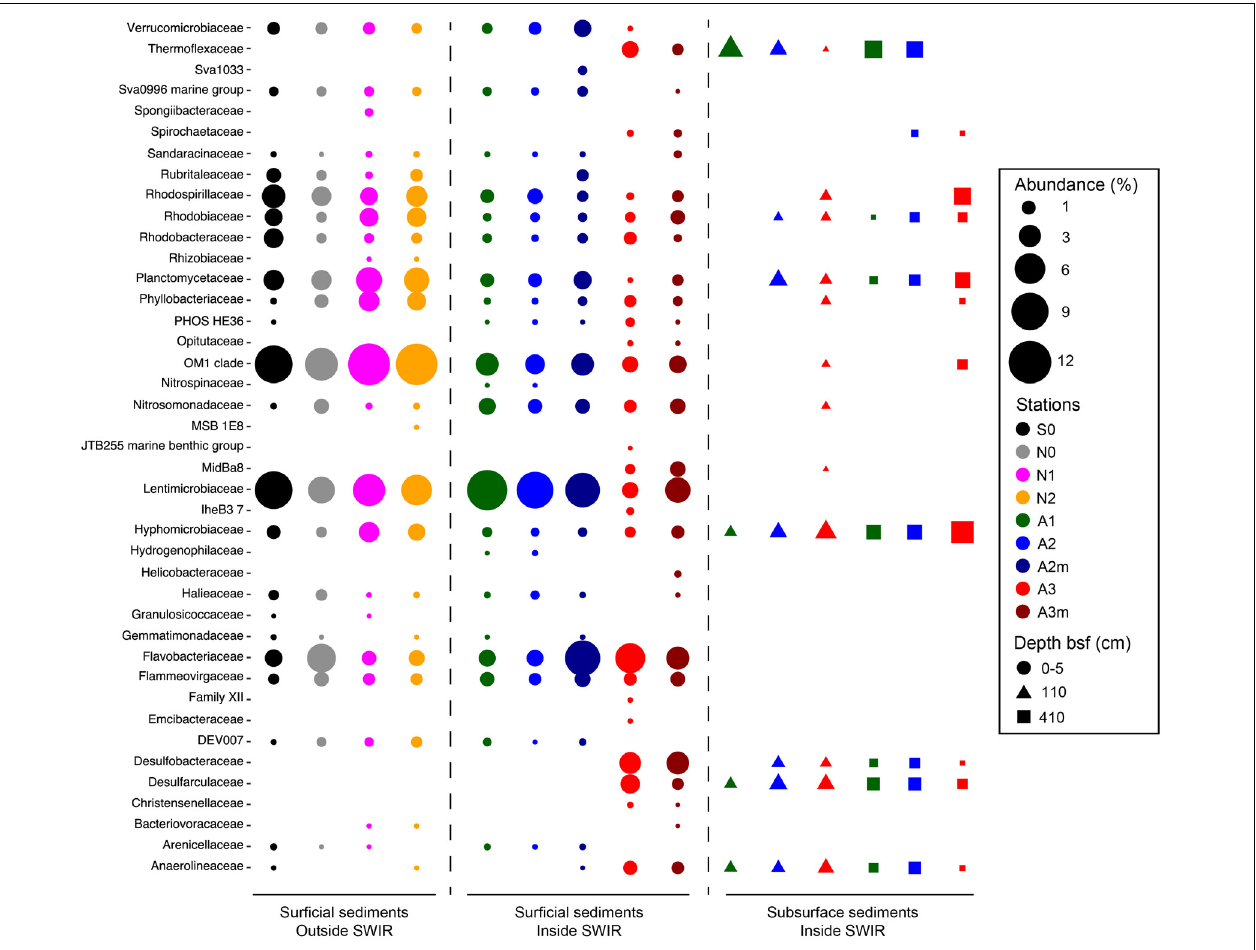
FIGURE 4 | Bacterial community composition in surficial and subsurface sediments at Family level. Here we reported Families responsible for differences between bacterial communities inside and outside the SWIR and between surficial and subsurface bacterial communities. Families were selected after PCA analysis carried out on Hellinger transformed dominant bacterial and archaeal taxa (i.e., OTU > 0.1%) comparing (i) 0–5 cm layer of A3–A3m versus all stations, (ii) 0–5 cm layer of stations inside SWIR (A1 and A2–A2m) versus outside SWIR stations (N0, N1, N2, and S0), and (iii) 0–5 cm layer of all stations versus subsurface layer of SWIR